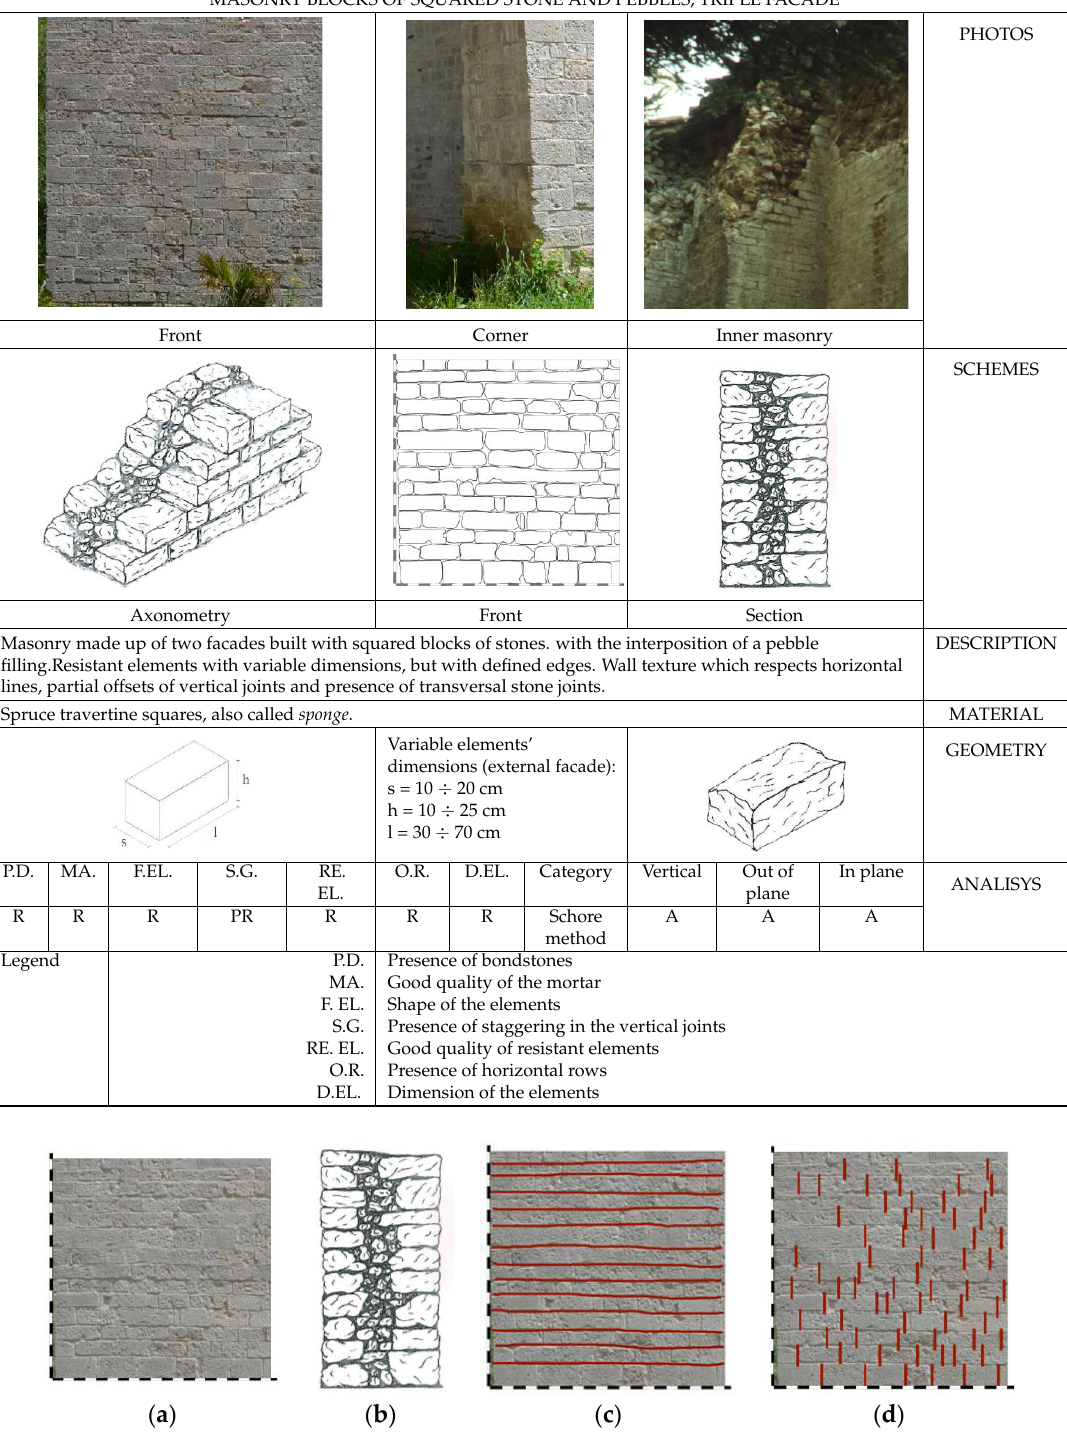
Table 2. Wall quality index evaluation. Source of the axonometry and section images: [49]. MASONRY BLOCKS OF SQUARED STONE AND PEBBLES, TRIPLE FACADE